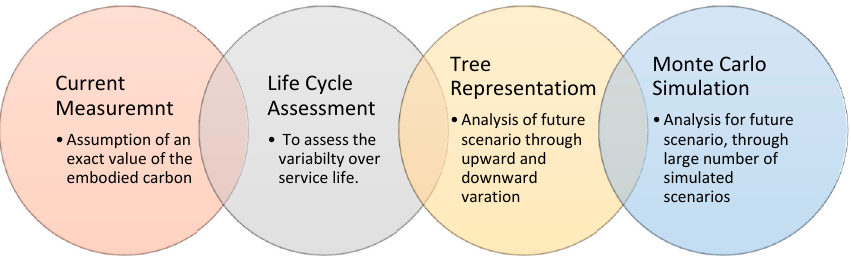
Figure 3. Probabilistic approaches for embodied carbon assessment.